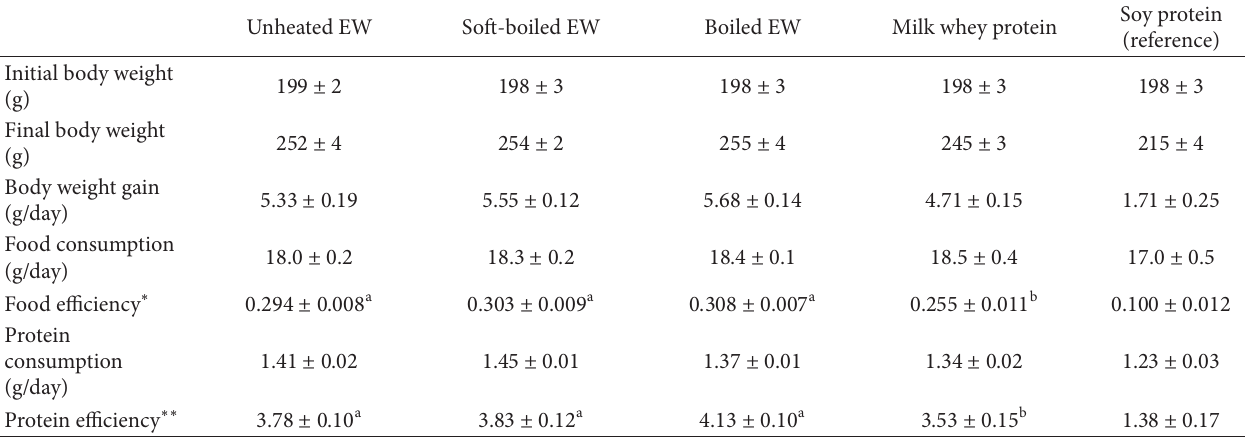
Table 1: Growth variables in rats fed a diet containing egg whites (EW) (unheated, soft-boiled, or boiled), milk whey protein, or soy protein.